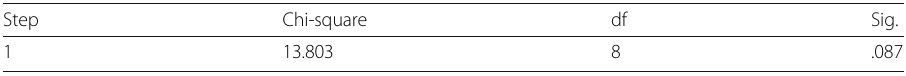
Table 5 Hosmer and Lemeshow test